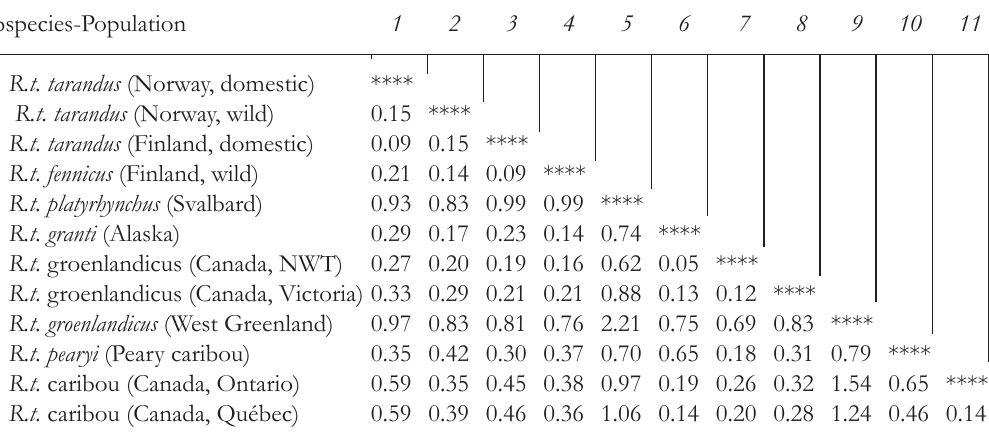
Table 3. Genetic distance (Nei, 1978) based on microsatellite variation in 13 loci in subspecies of reindeer and